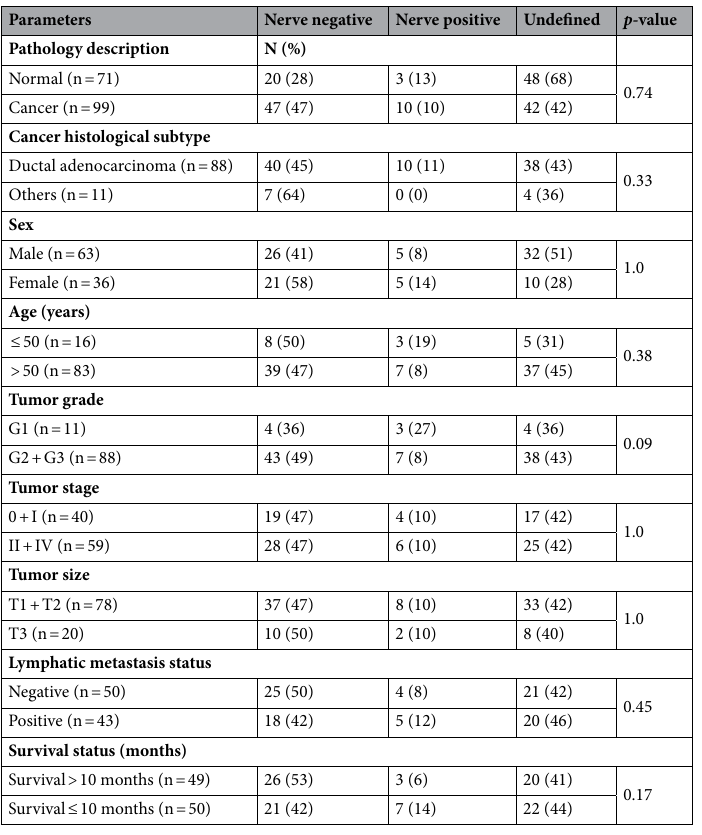
Table 1. Nerve infiltration in the pancreatic tumor microenvironment and its correlation with clinicopathological variables. p -values were calculated by the chi-squared test between nerve positive versus nerve negative samples. A tumor was considered positive only when nerves could be confirmed by using 3 neuronal markers (S-100, PGP9.5 and GAP-43).